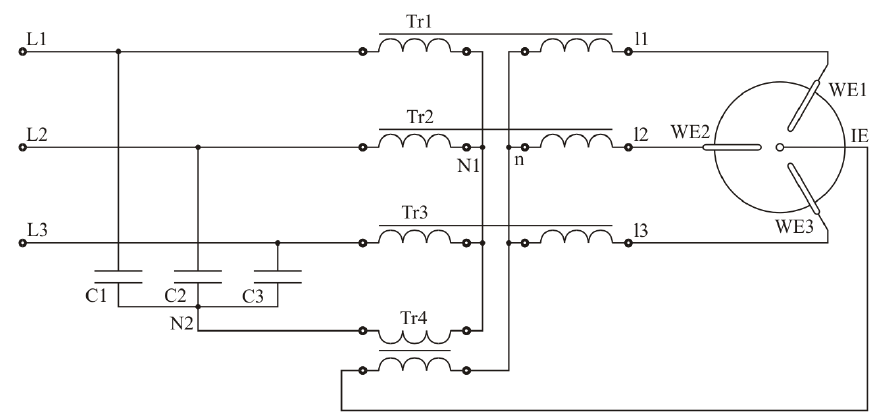
Figure 4. IPSS with artificial neutral point from three capacitors connected in star—N2 artificial neutral point, N1 and n—neutral points according to primary and secondary side of transformers Tr1, Tr2, and Tr3 connected in star [43].